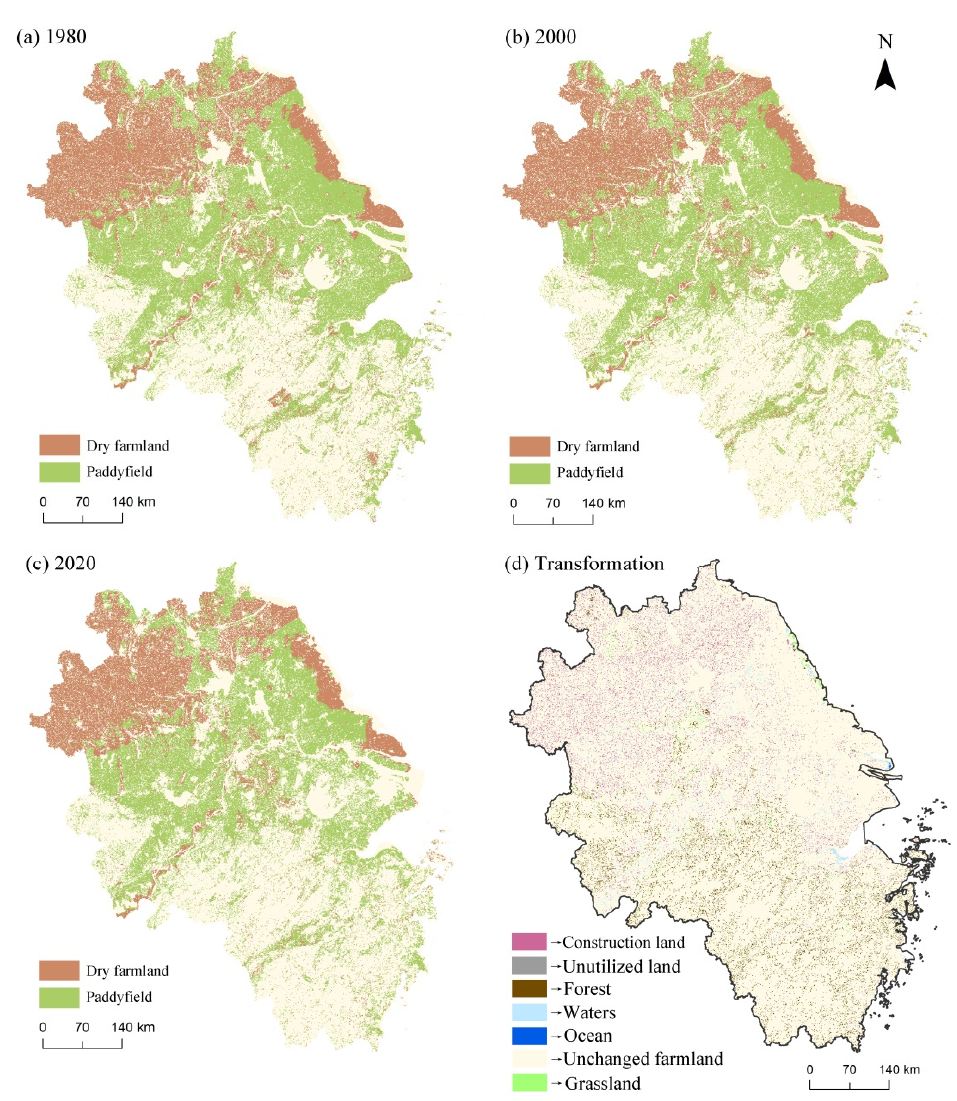
Figure 4. Changes of cultivated land in the Yangtze River Delta over the past 40 years. ( a – c ) Distributions of cultivated land in 1980, 2000 and 2020, respectively; ( d ) conversion of cultivated land to other land types from 1980 to 2022. For the instructions of copyright for the base map, see Figure